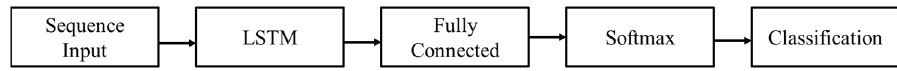
Figure 6. Block diagram of LSTM architecture for the time series classification. The network starts with a sequence input layer followed by an LSTM layer. To predict class labels, the network ends with a fully connected layer, a softmax layer and a classification output layer. The LSTM layer architecture is illustrated in Figure